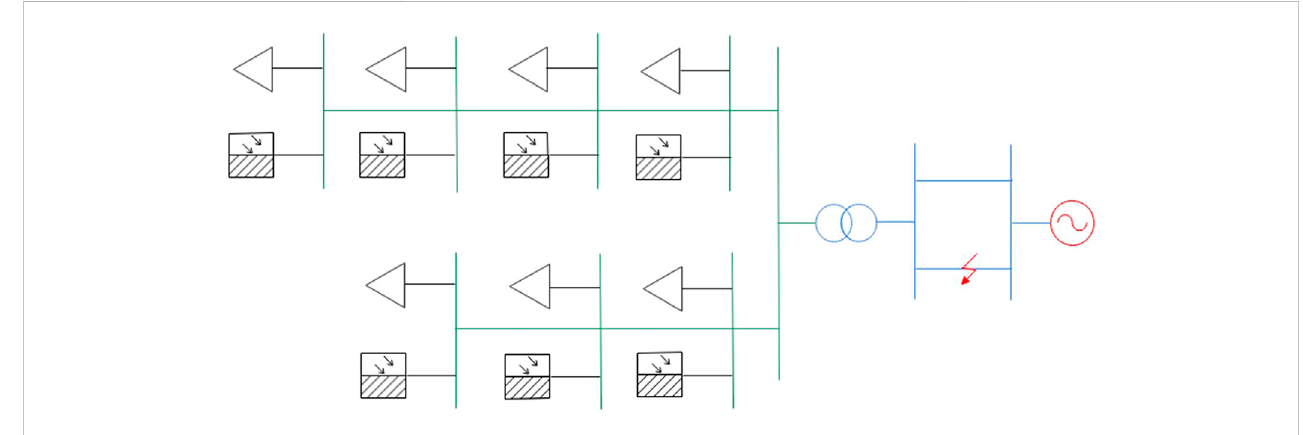
FIGURE 4 Schematic of the test